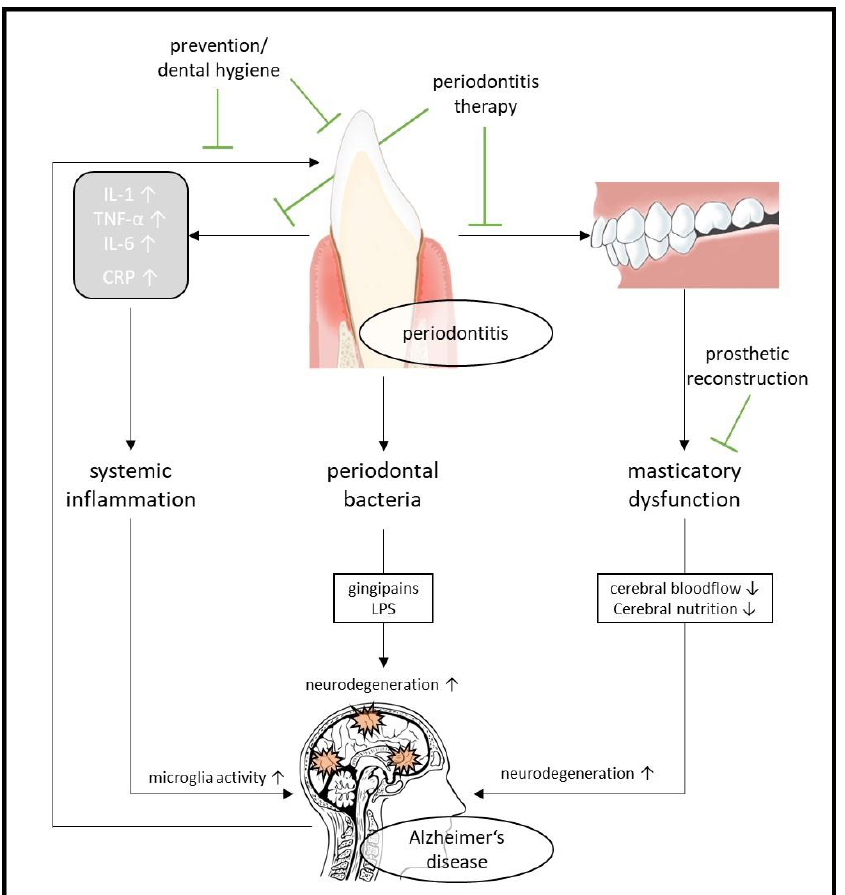
Figure 5. Schematic (simplified) diagram of currently discussed relationships between oral status and Alzheimer ’ s disease and possible dental interventions.